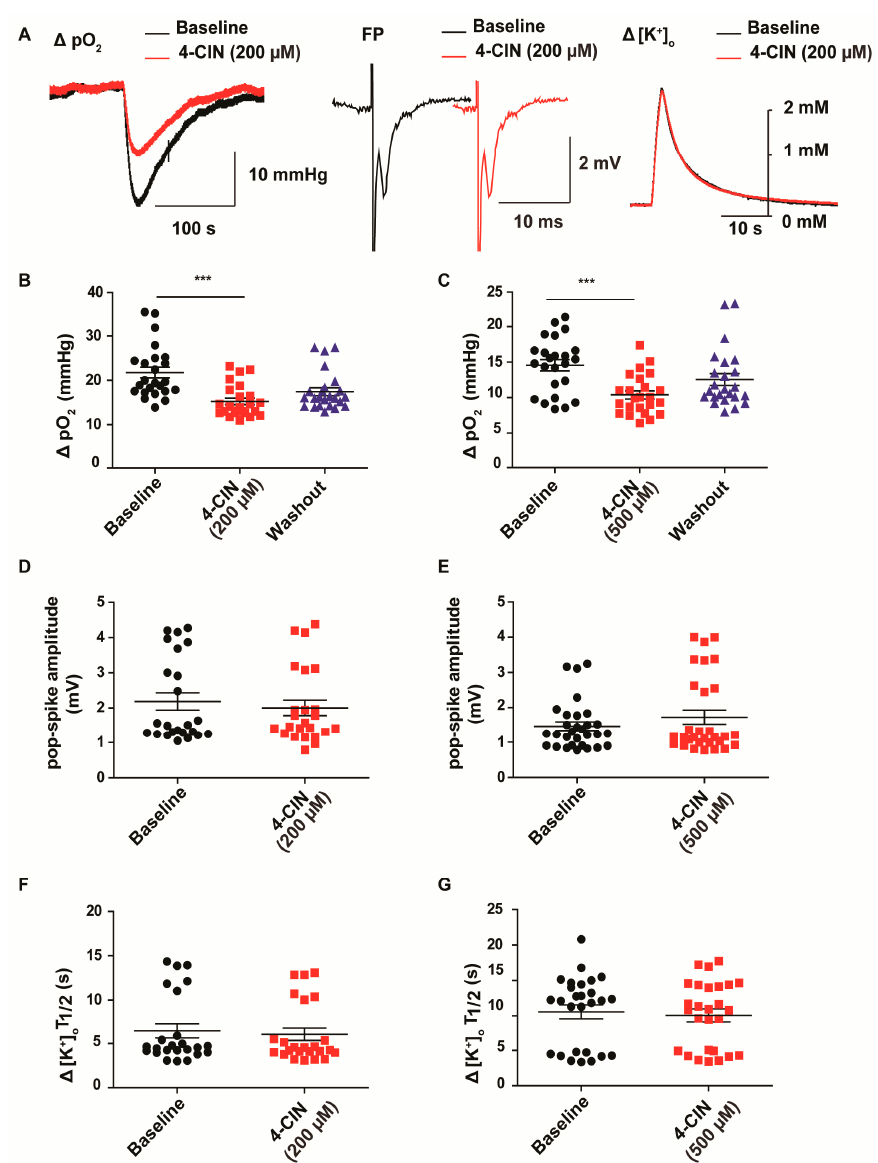
layers V/VI. Application of 4-CIN at a concentration which preferentially blocks lactate uptake via MCT2 (200 µ M) significantly reduced stimulus induced ∆ pO 2 from 21.8 ± 1.2 to 15.3 ± 0.7 mmHg (Figure 1A,B; paired t -test, p < 0.001, n = 9, 5 patients) in line with the findings in rat brain slices. Baseline pO 2 of 504.4 ± 102.7 mmHg was measured in interface chamber under 95% O 2 and 5% CO 2 . Despite the decrease in ∆ pO 2 , there was no obvious change in baseline pO 2 suggesting that lactate contribution to the basal oxidative metabolism is negligible.